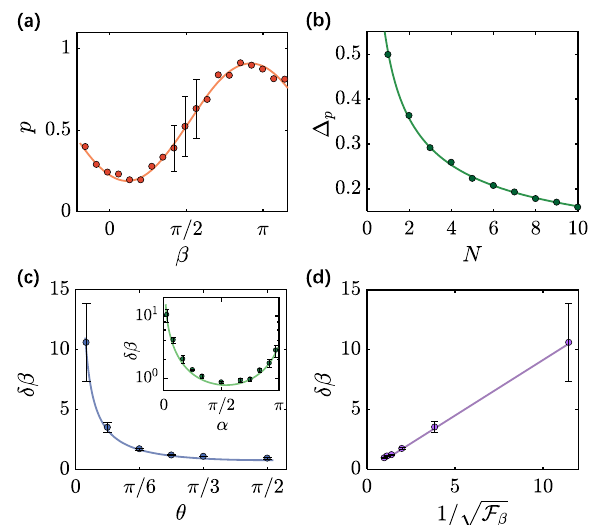
Fig. 3 Saturating the quantum Cramér – Rao bound. a The Ramsey interferometry measurement signal p ¼ S h i . The measurement data allows us to obtain the susceptibility χ α = ∂ p / ∂ β of the measurement signal close to the working point β = π /2. The error bars represent the uncertainty of the parameter estimation Δ p ¼ ½ S 2 with the number of repetitions N = 9. The parameters are θ = π /3, α = π /2, ξ = (2 π )2.27 MHz and A = (2 π )11.34 MHz. b The uncertainty of the parameter estimation Δ s as a function of the number of repetitions N can be fi tted by a function of the form Δ p ¼ Δ 0 = (green curve). c The optimal measurement sensitivity δβ (achieved by the projective measurement P α with α = π /2) by using different θ - dependent resource states ψ θ ð 0 Þj i . Inset: The sensitivity δβ , achieved by applying the projective measurement P α as a function of α when θ = π /2 and β = π /2, shows that the optimal measurement sensitivity in our Ramsey interferometry experiment is obtained when α = π /2. The green curve is obtained from numerical simulation, see further details in Fig. S4. d The linear relation δβ / 1 =